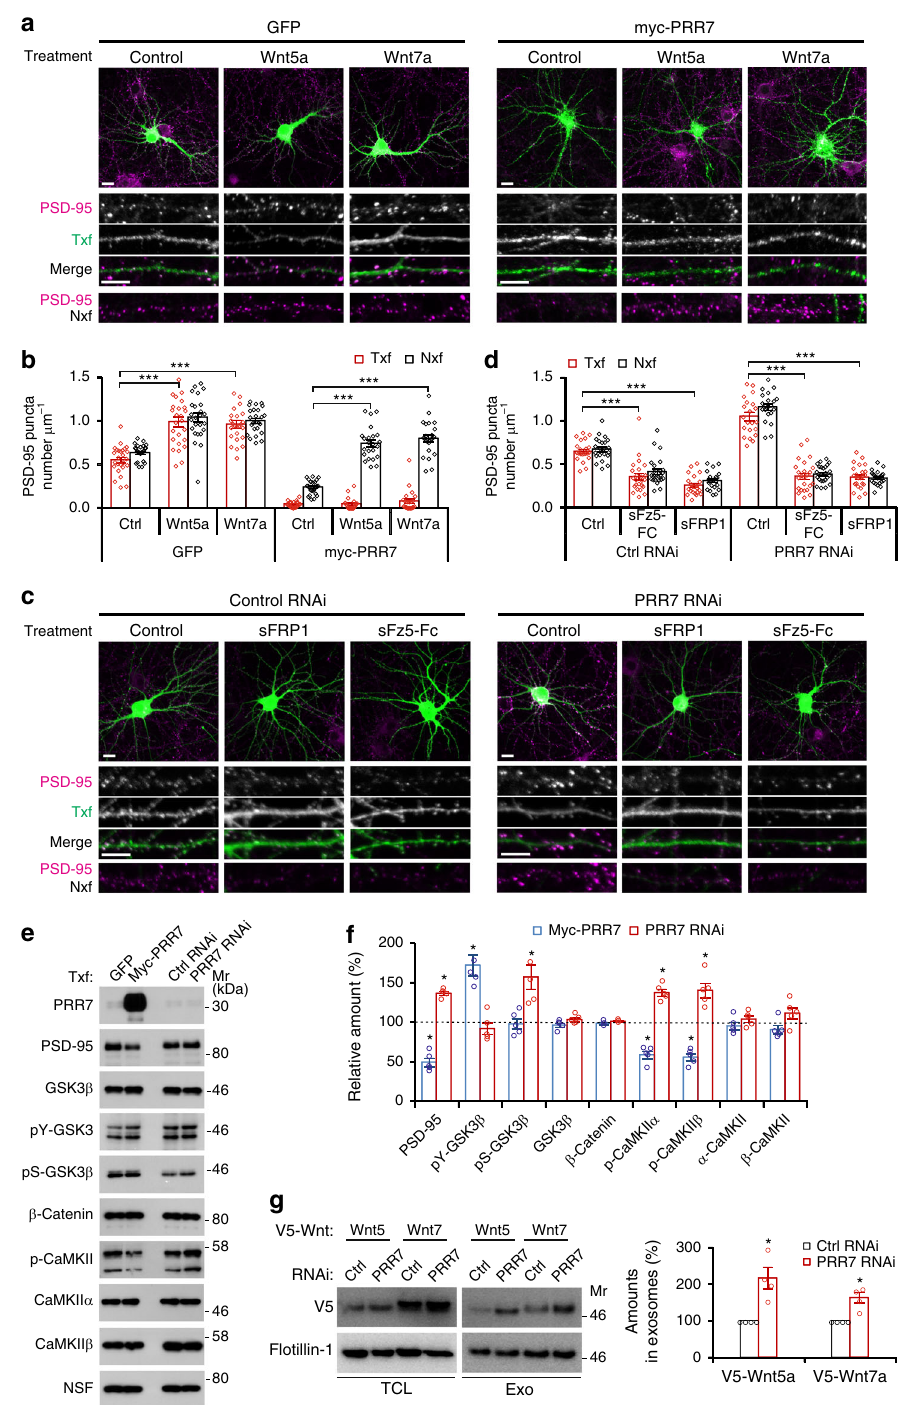
Fig. 8 PRR7 inhibits synaptogenic Wnt signaling. a , b Effect of exogenous application of Wnt5a and Wnt7a on PRR7-induced loss of PSD-95 clusters. Representative immuno fl uorescent images of PSD-95 ( a ) and quantitation of data ( b ). n = 23 – 26. c , d Effect of soluble Wnt inhibitors on PRR7 knockdown- induced increase of PSD-95 clusters. Representative immuno fl uorescent images of PSD-95 ( c ) and quantitation of data ( d ). n = 22 – 24. e , f Modulation of Wnt signaling by PRR7. Representative immunoblots showing the effect of PRR7 overexpression or knockdown on the indicated Wnt signaling components ( e ) and quanti fi cation of the data ( f ). n = 3 – 5. g Effect of PRR7 knockdown on the exosomal secretion of Wnt5a and Wnt7a. n = 4. Data are mean ± SEM. Scale bars, 5 μ m. Two-way ANOVA ( b , d ), post hoc Tukey ’ s test: F 2,148 = 66.62 ( b , GFP), F 2,138 = 76.96 ( b , myc-PRR7), F 2,130 = 86.74 ( d , Ctrl RNAi), and F = 336.6 ( d , PRR7 RNAi). *** P < 0.0001; Student t test ( f , g ) and * P < 0.05. Mr relative molecular 2,134